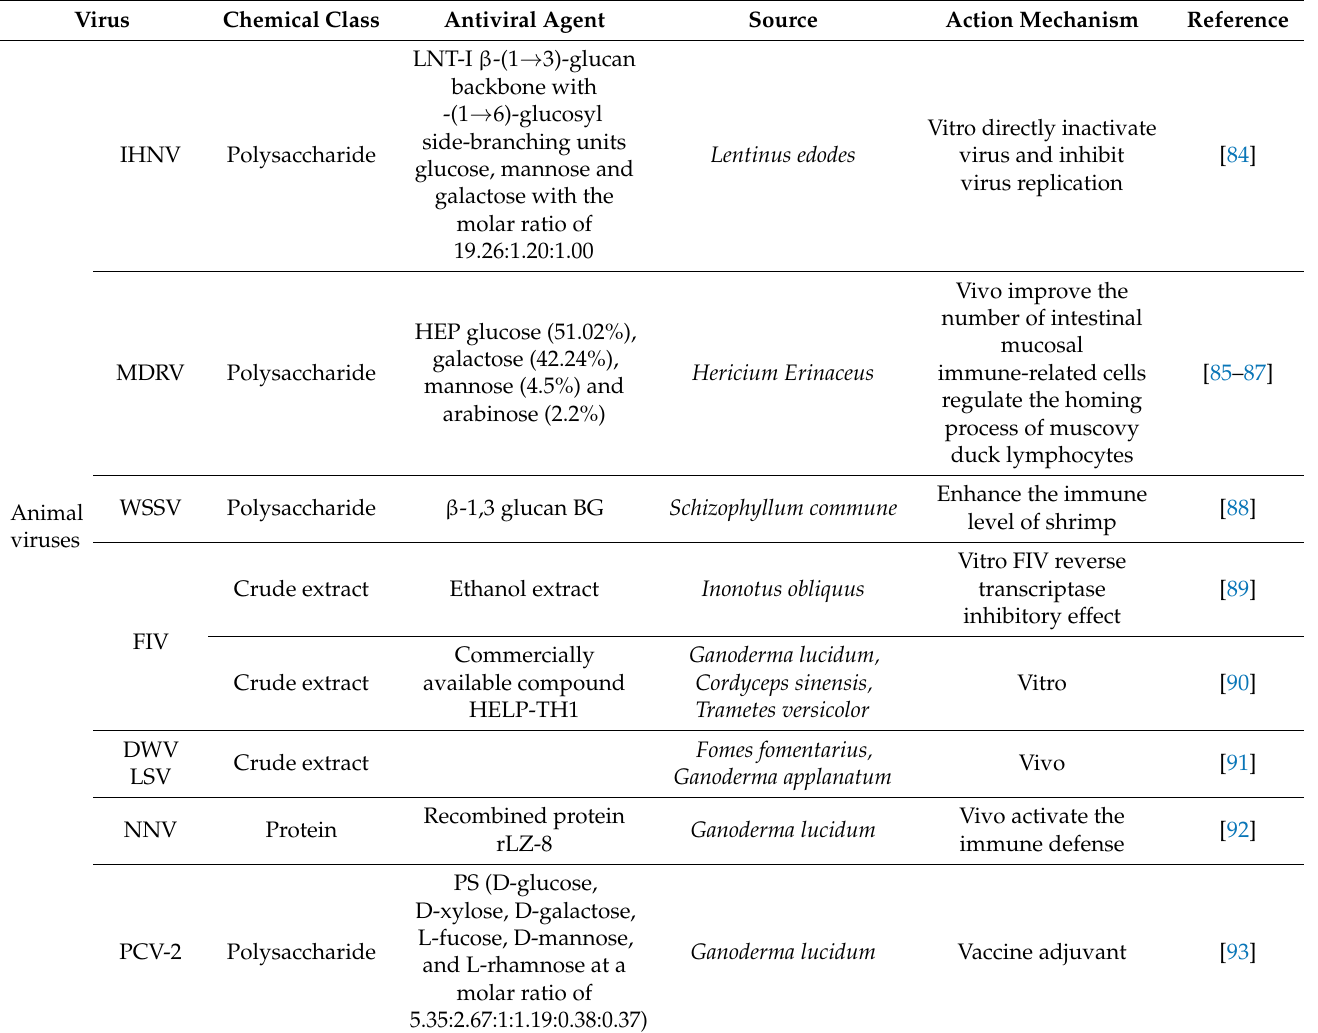
Table 2. Antiviral activities of medicinal fungi and their mechanism of action in plant and animal